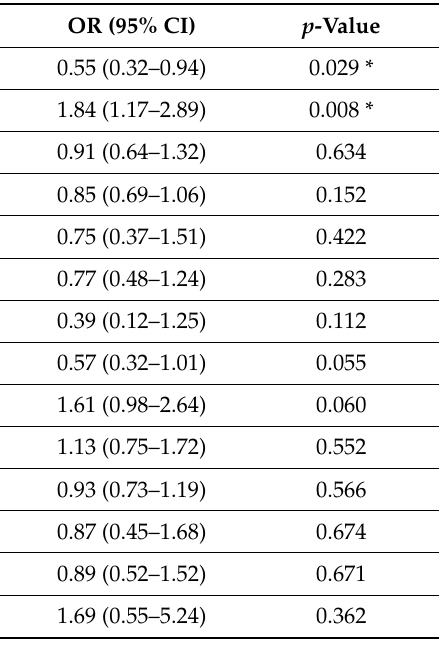
Table 3. Multivariate binary logistic regression of the clinical factors influencing the categorical outcomes (0: no, 1: yes). Age: (0) <65, (1) ≥ 65; Sex: (0) M, (1) F; ECOG PS: (0) 0, (1) 1, (2) ≥ 2; Comorbidity: (0) no, (1) ≤ 2, (2) ≥ 3; Setting: (0) adjuvant and neoadjuvant, (1) metastatic; ICIs treatment: (0) no, (1) yes; Vaccine: (0) with mRNA, (1) with viral vector. *: p -values reaching statistical